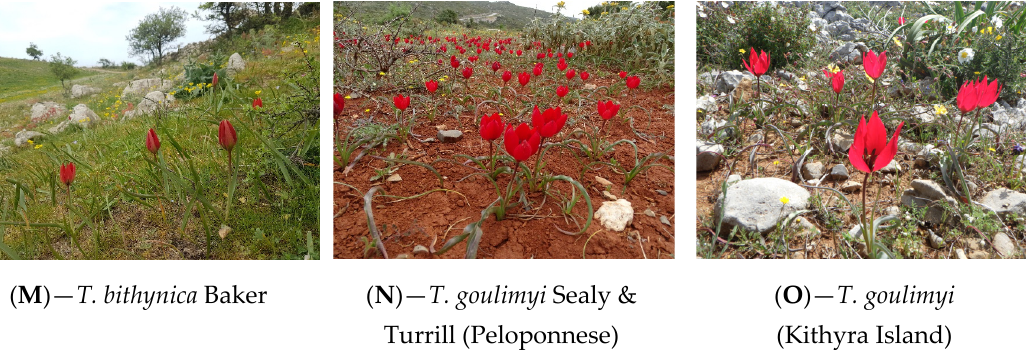
Figure 1. Flowering individuals of mainly segetal ( A – H ) and rock-dwelling or non-segetal ( I – O ) wild-growing tulips of Greece employing different biogeographical groups such as Greek endemic ones ( T. bakeri , T. cretica , T. doerfleri , T. goulimyi , T. hageri , T. orphanidea ), sub-endemic ones extending to Turkey and/or the Balkans ( T. bithynica , T. saxatilis , T. undulatifolia ), Mediterranean ( T. australis ) and Asiatic ones naturalized in Greece ( T. aegenensis , T. clusiana , T. raddii ). Table 1. Collection details and IPEN (International Plant Exchange Network) accession numbers associated with the living material samples regarding the Tulipa spp. from Greece studied herein. Different Tulipa spp. are arranged alphabetically. For each species, the letter in the parentheses de- notes different tulip samples collected (1–6 samples per species).